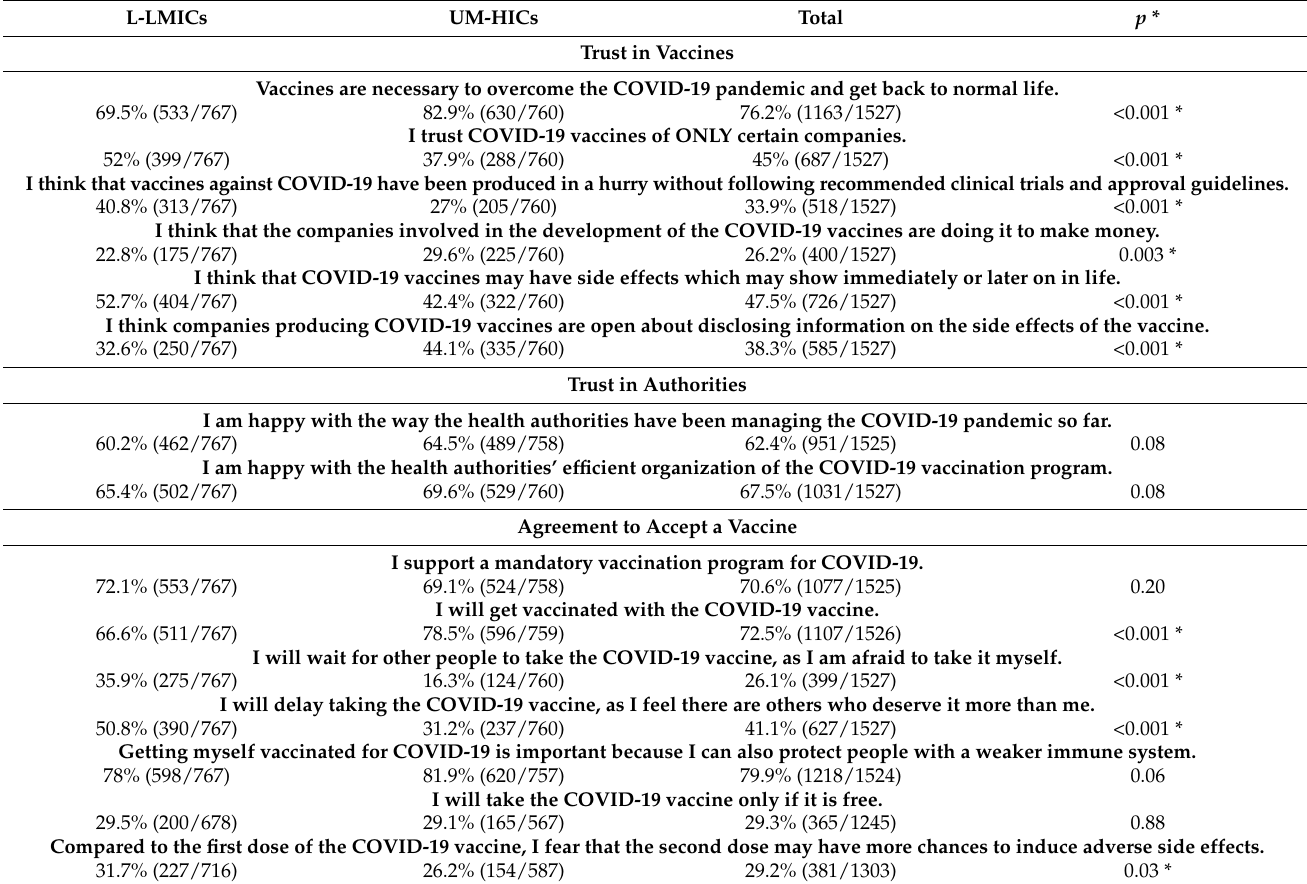
Table 2. Comparison of responses to different survey questions between L-LMICs and UM-HICs– Data are presented as % ( n